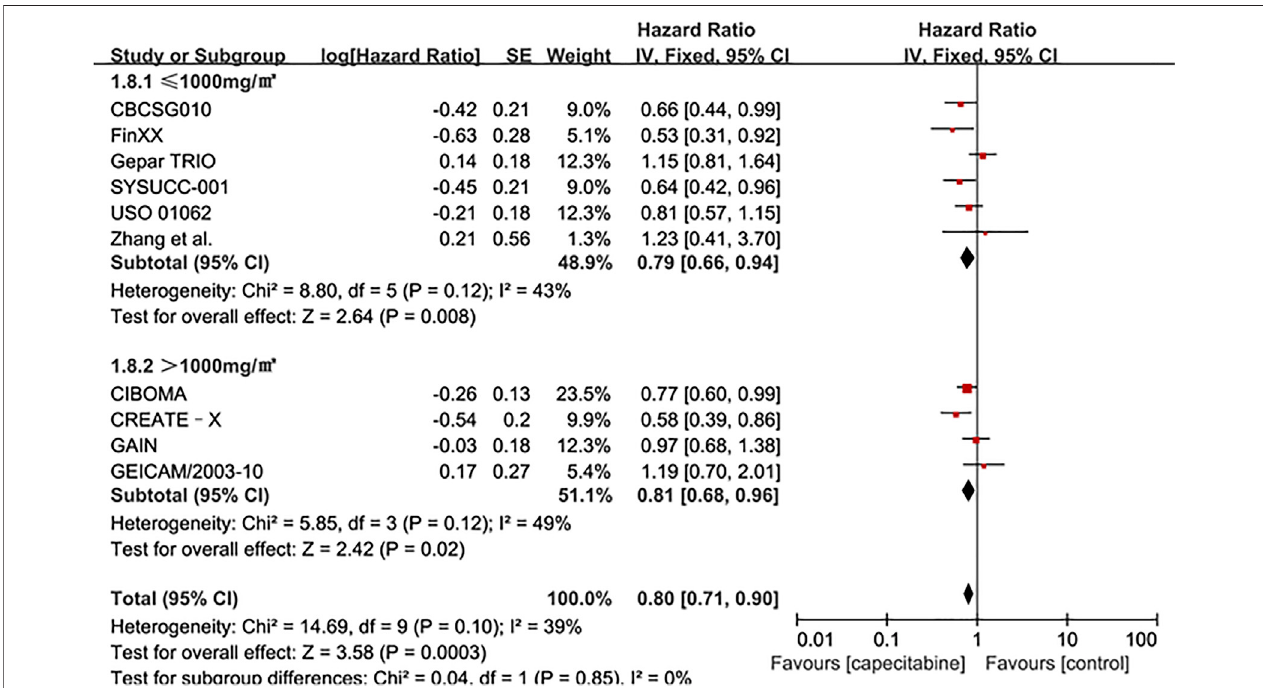
FIGURE 4 | Subgroup analysis of the effect of capecitabine adjuvant chemotherapy dose on DFS in TNBC patients.